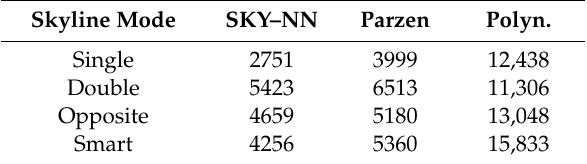
Table 4. Total time needed on average to perform a classification task on the synthetic